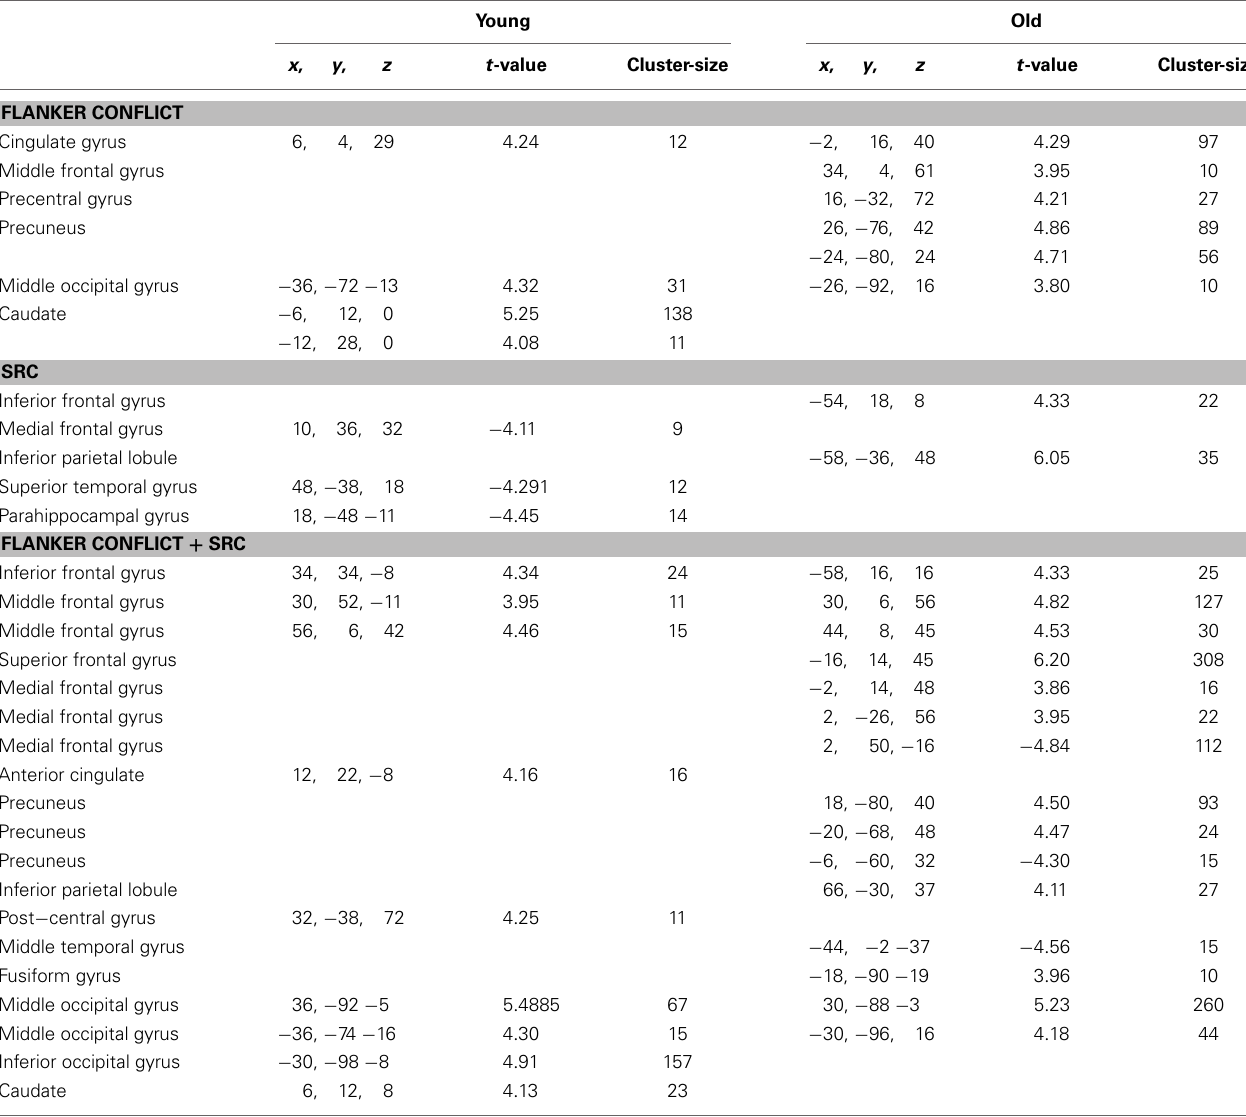
Table 2 | Peak activations for the Flanker [FiSc > FcSc], SRC [FcSi > FcSc], and double conflict (Flanker + SRC) [fisi > fcsc] contrasts, for younger and elderly